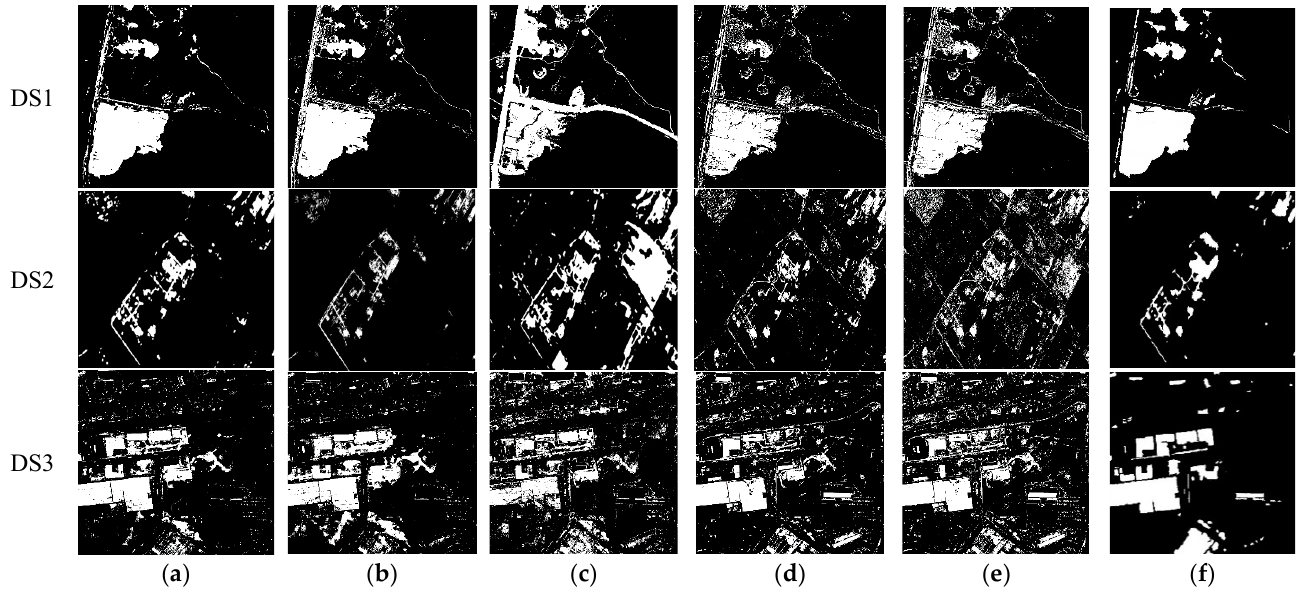
Figure 5. Change detection results in the second experiment: ( a ) IRMAD; ( b ) ISFA; ( c ) PCA; ( d ) CVA- SIFCM; ( e ) DI-Kmeans; and ( f ) proposed method. Table 3. Quantitative evaluation of change detection results in the second experiment.